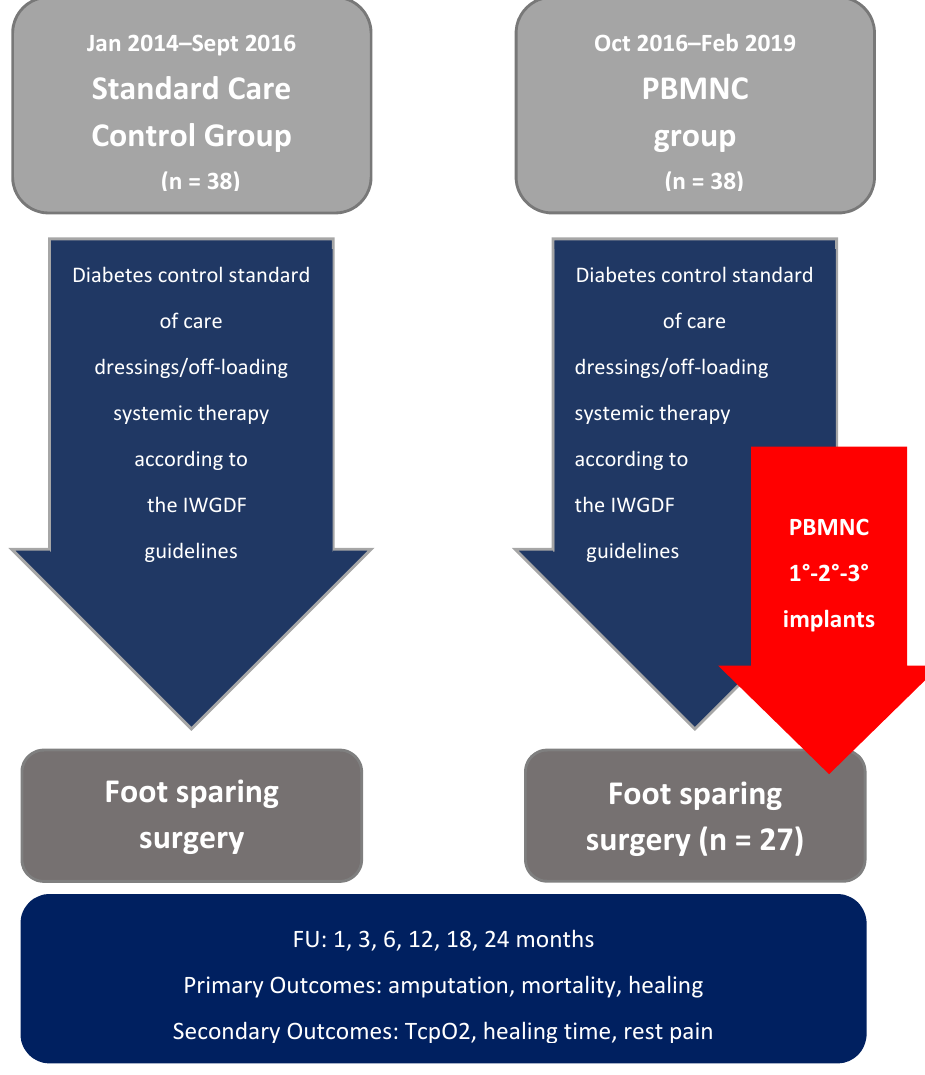
Figure 1. Study flow diagram.